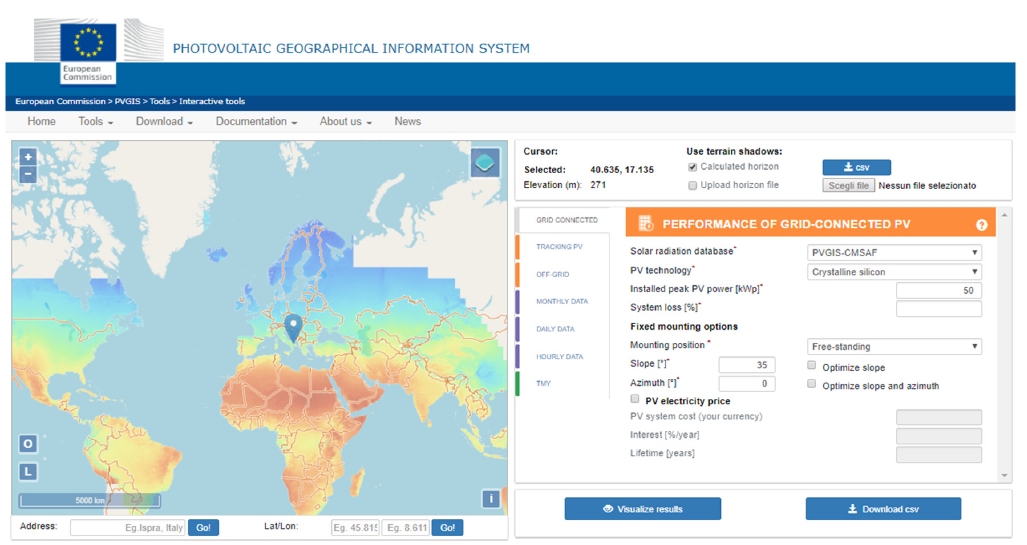
Figure 1. PVGIS of the European Commission Joint Research Centre (EC-JRC).